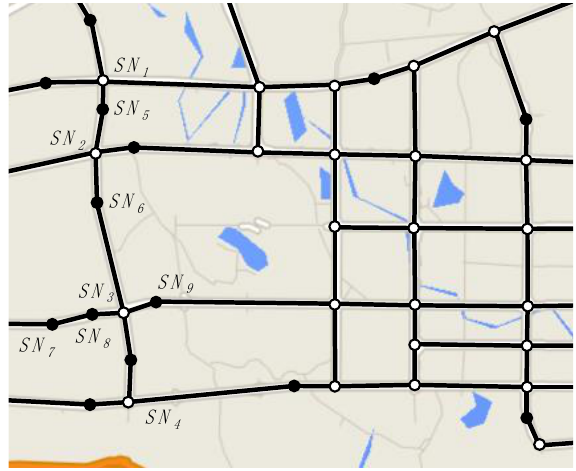
Figure 1. Representing road network data by nodes and segments.